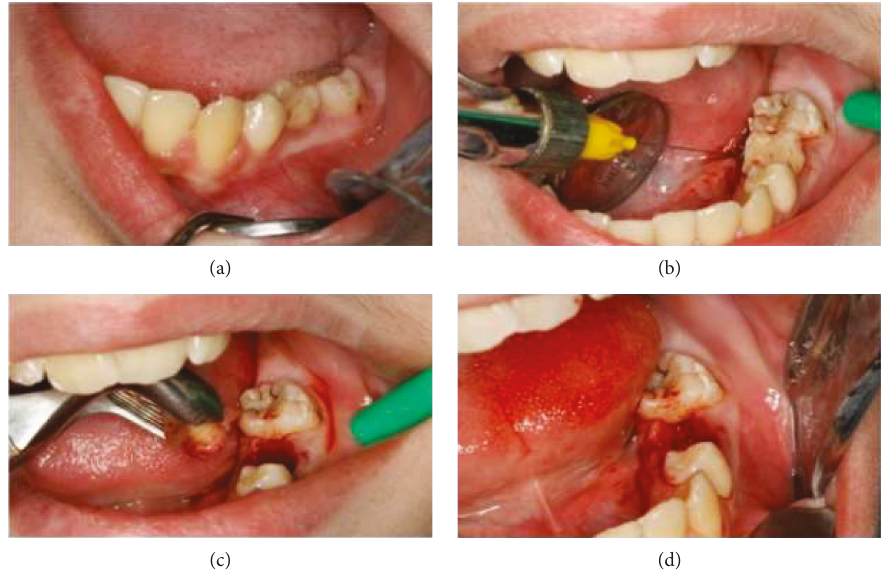
Figure 4: Marsupialization of the cystic lesion after extraction of the deciduous second molar, revealing retraction to visualize the surgical site at fi rst (a), then anesthetizing the site (b), followed by extraction of the primary second molar and drainage (c), and fi nally opening of the surgical site after marsupialization (d).